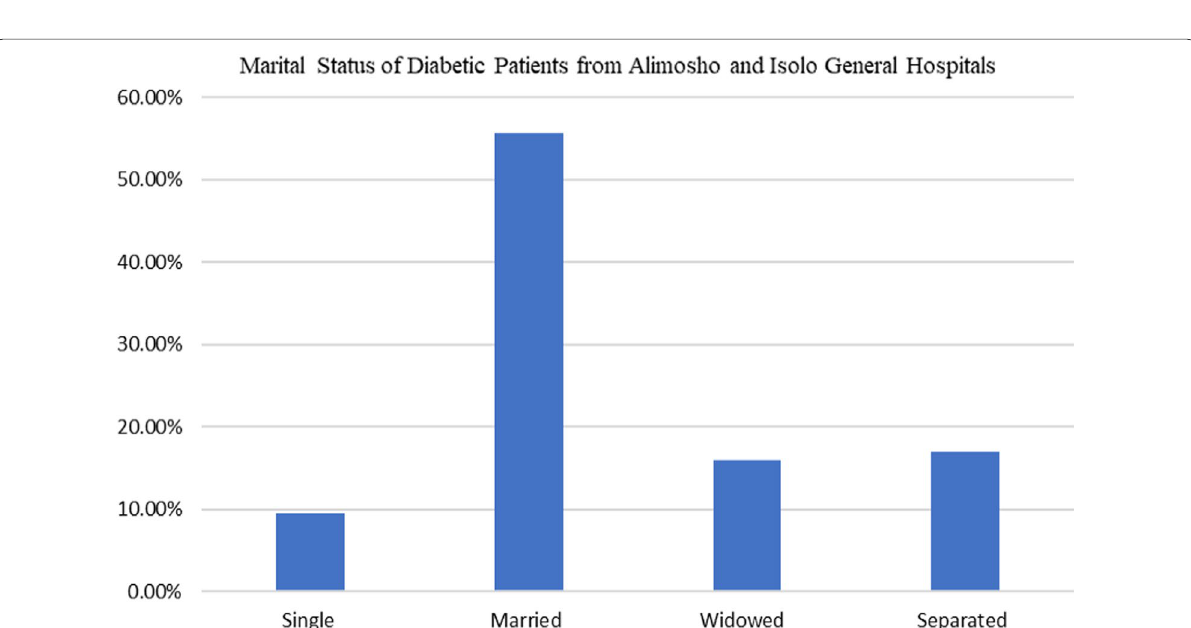
Fig. 5 Marital status of diabetic patients in Alimosho and Isolo General